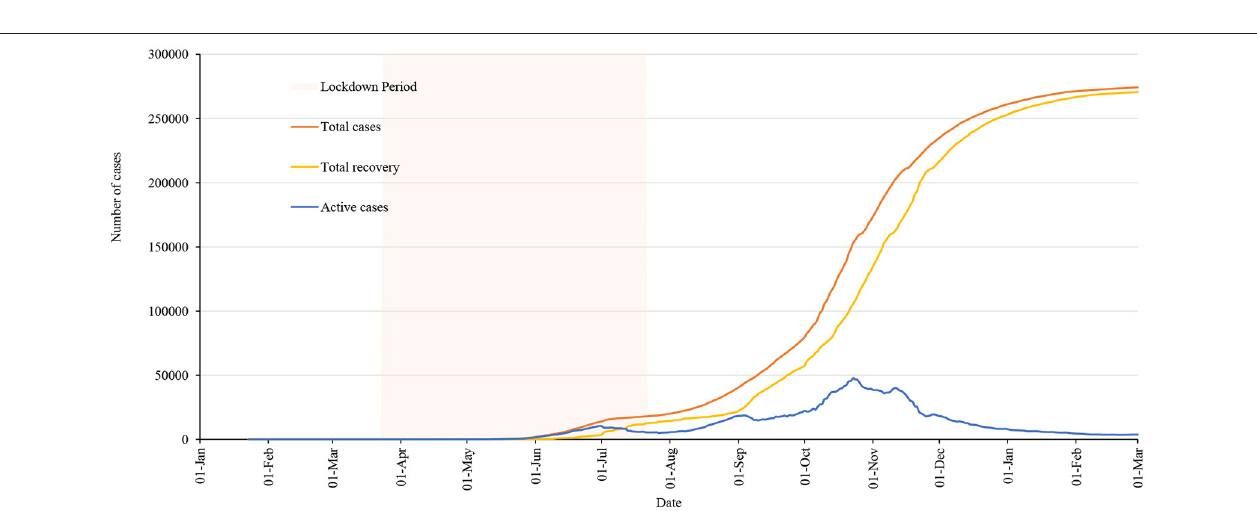
FIGURE 8 | Total cases, recovery, and active cases in Nepal as of 01 March 2021.